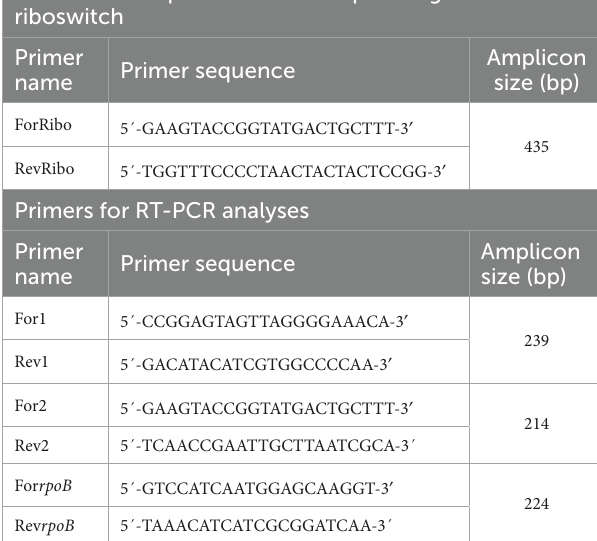
TABLE 2 Primers used within the study. Primers for amplification and sequencing of the